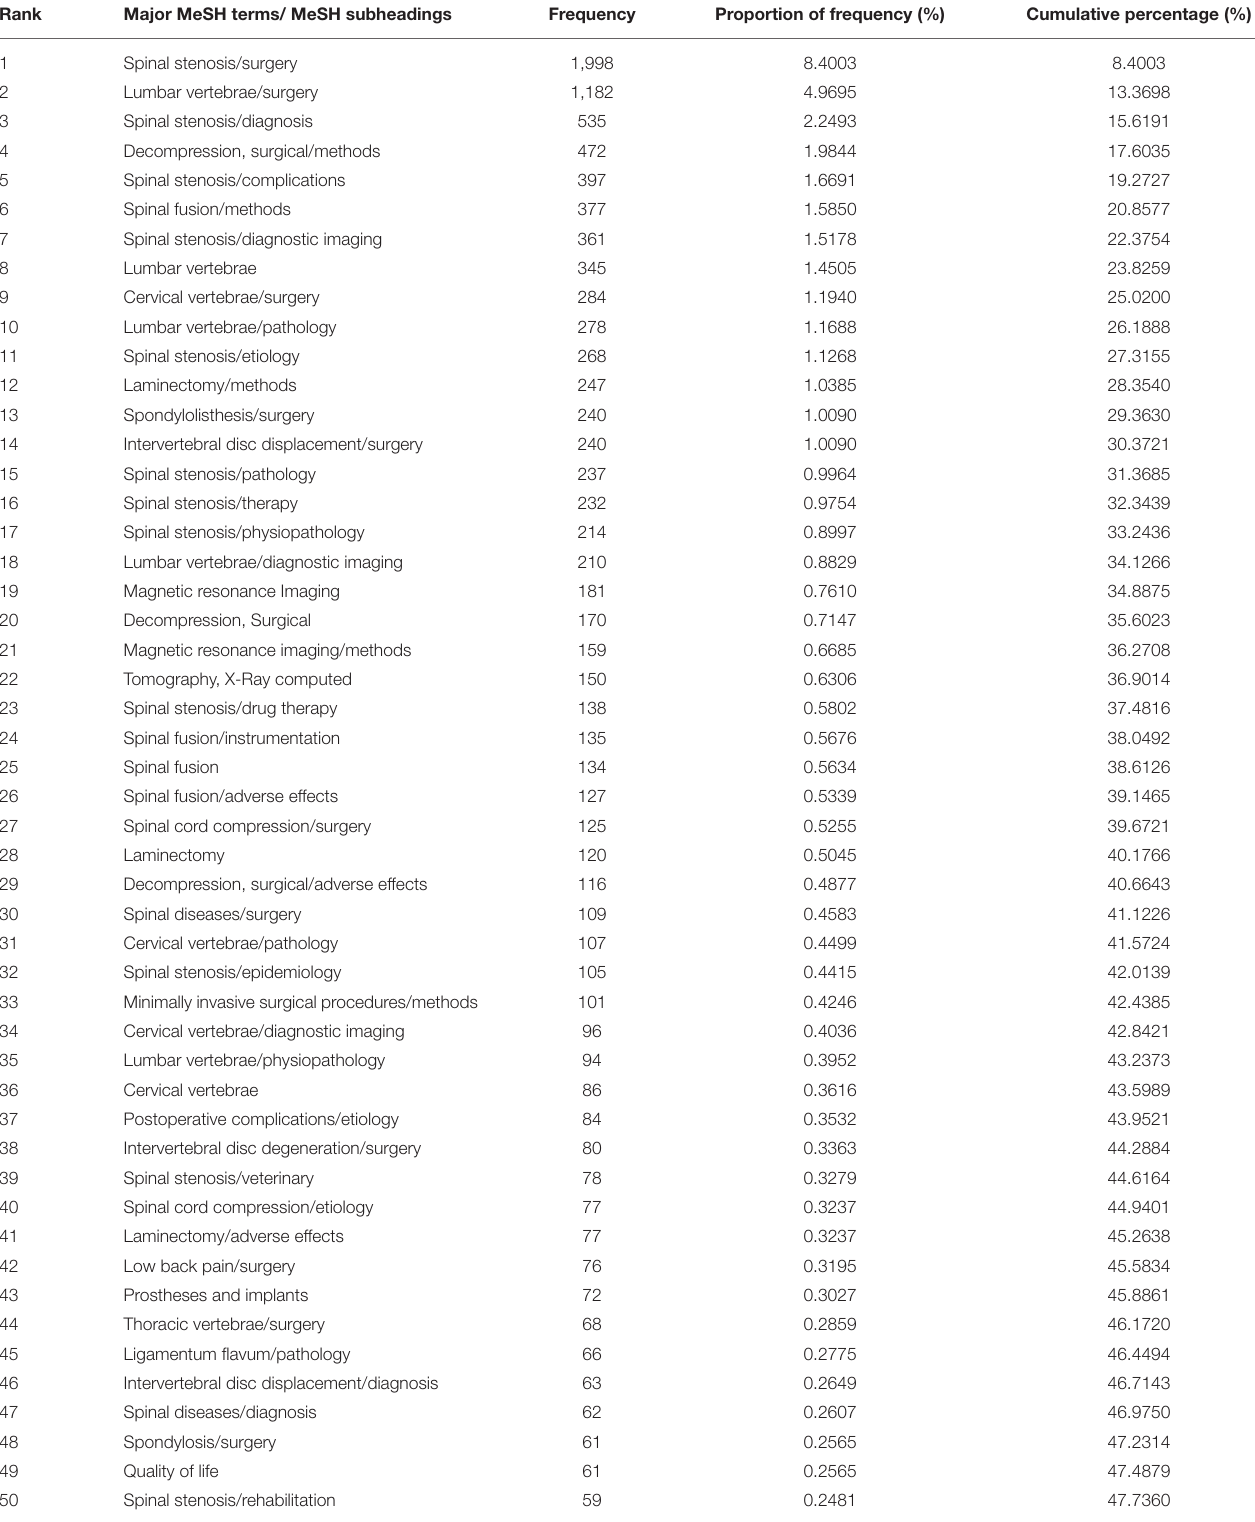
TABLE 5 | High-frequency major MeSH terms from the involved publications on spinal stenosis ( n = 23,785). Rank Major MeSH terms/ MeSH